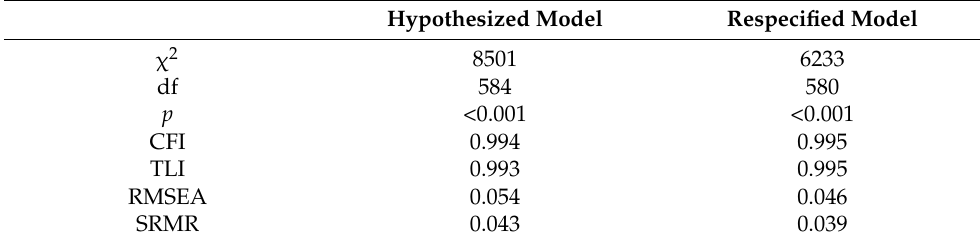
Table 7. Fit indices of the hypothesized and respecified model.